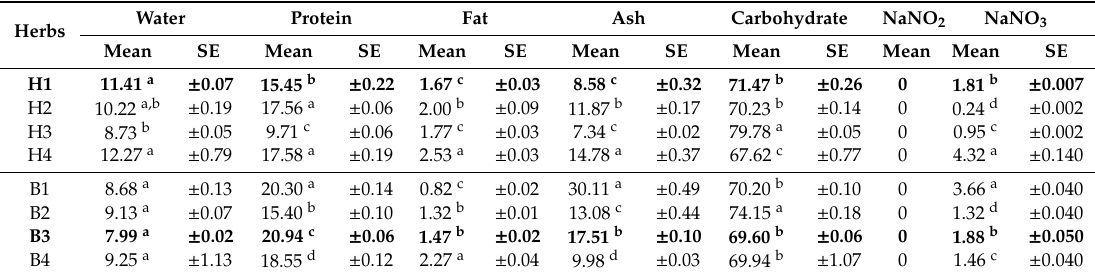
Table 2. Proximate composition of herbs from di ff erent retailers [g / 100 g] (mean values ± standard errors